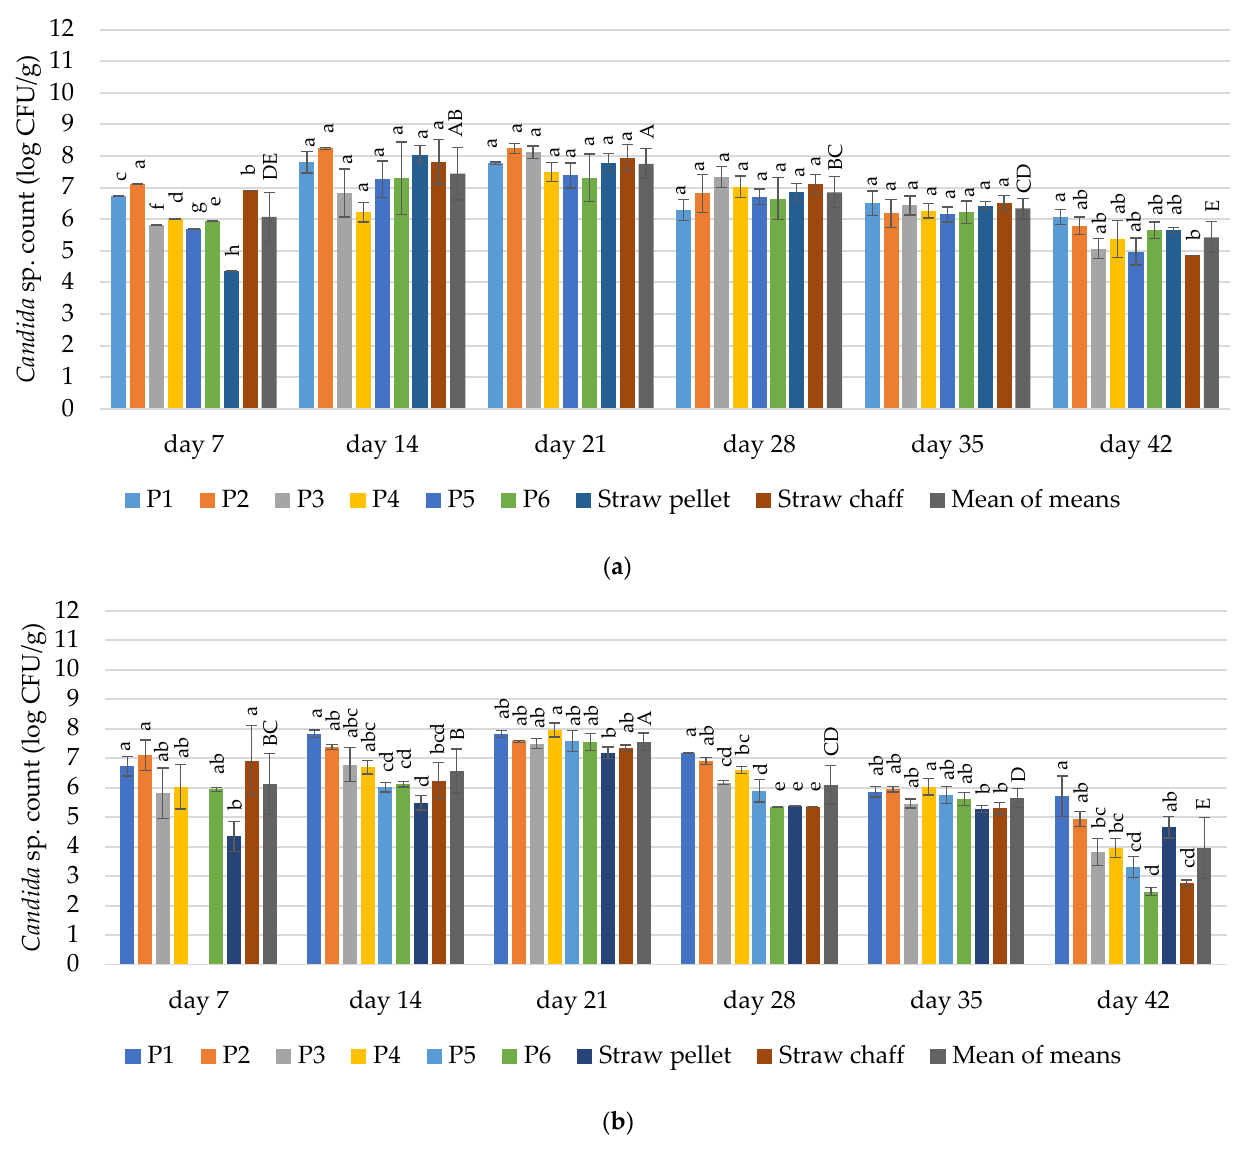
Figure 8. Changes in the count of microorganisms of Candida sp. in the tested bedding materials: ( a ) 1st experimental cycle; ( b ) 2nd experimental cycle. All values are means of three independent replicates ± SD, except the last bars for each day, which are the means-of-means. For each day, means with a common lowercase letter are not significantly different by the Tukey test at the 5% level of significance. For different days, means-of-means with a common uppercase letter are not significantly different by the Tukey test at the 5% level of significance. Pairwise comparisons between materials are presented only for observations from the same day. Pairwise comparisons between days are presented only for means-of-means. No pairwise comparisons between cycles are presented.